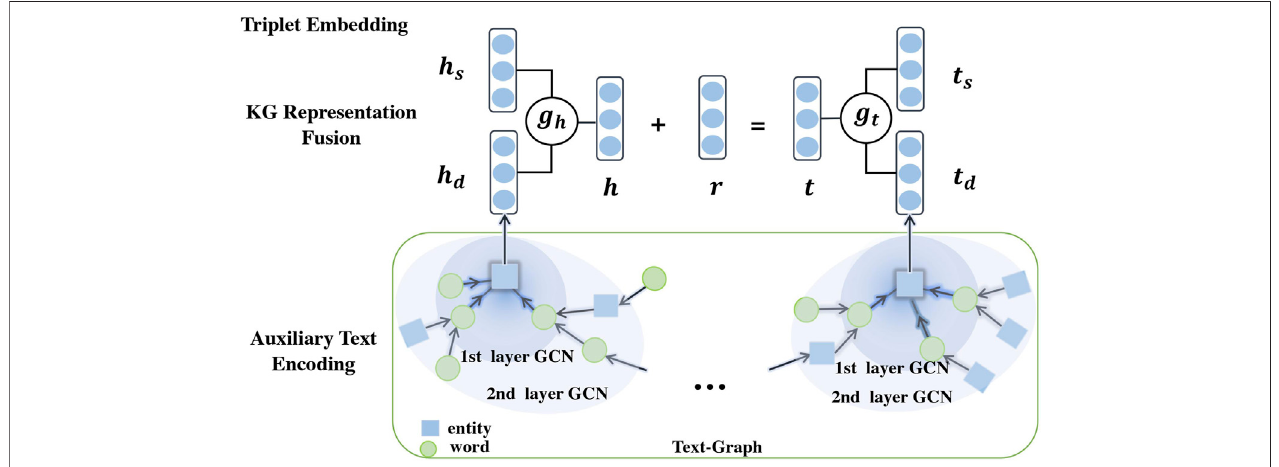
FIGURE 2 | Illustration of Teger for text-graph enhanced KG